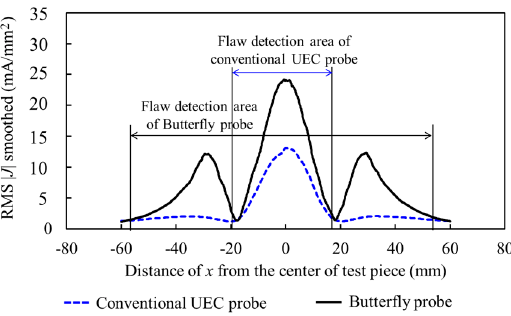
Figure 6. Eddy current density in the x -direction on the surface of the aluminium test piece using butterfly and conventional UEC probes.